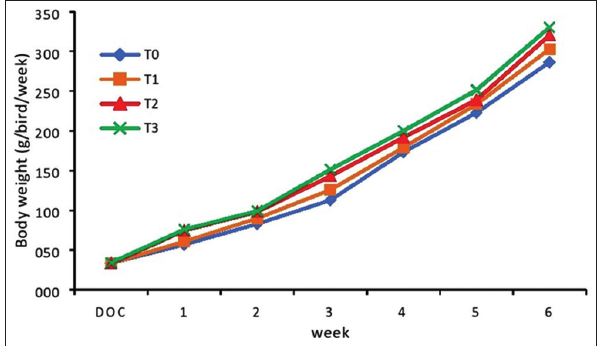
Figure-1: Relationship between diet treatment and body weight of native chickens during the starter phase (1-6